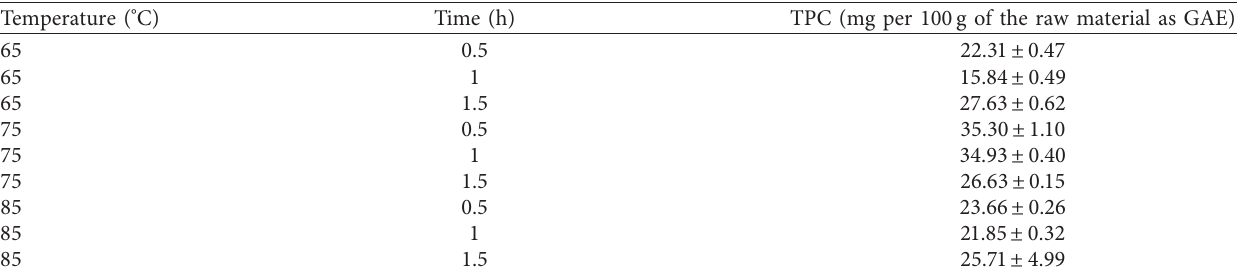
Figure 1: Plot of the total polyphenol content in mg per 100g of the raw material as gallic acid equivalent, recorded over different temperature and time combinations. The error bars represent the standard deviation of triplicated measurements in four separate sample runs ( n � 144). Table 2: Total polyphenol content under different time-temperature